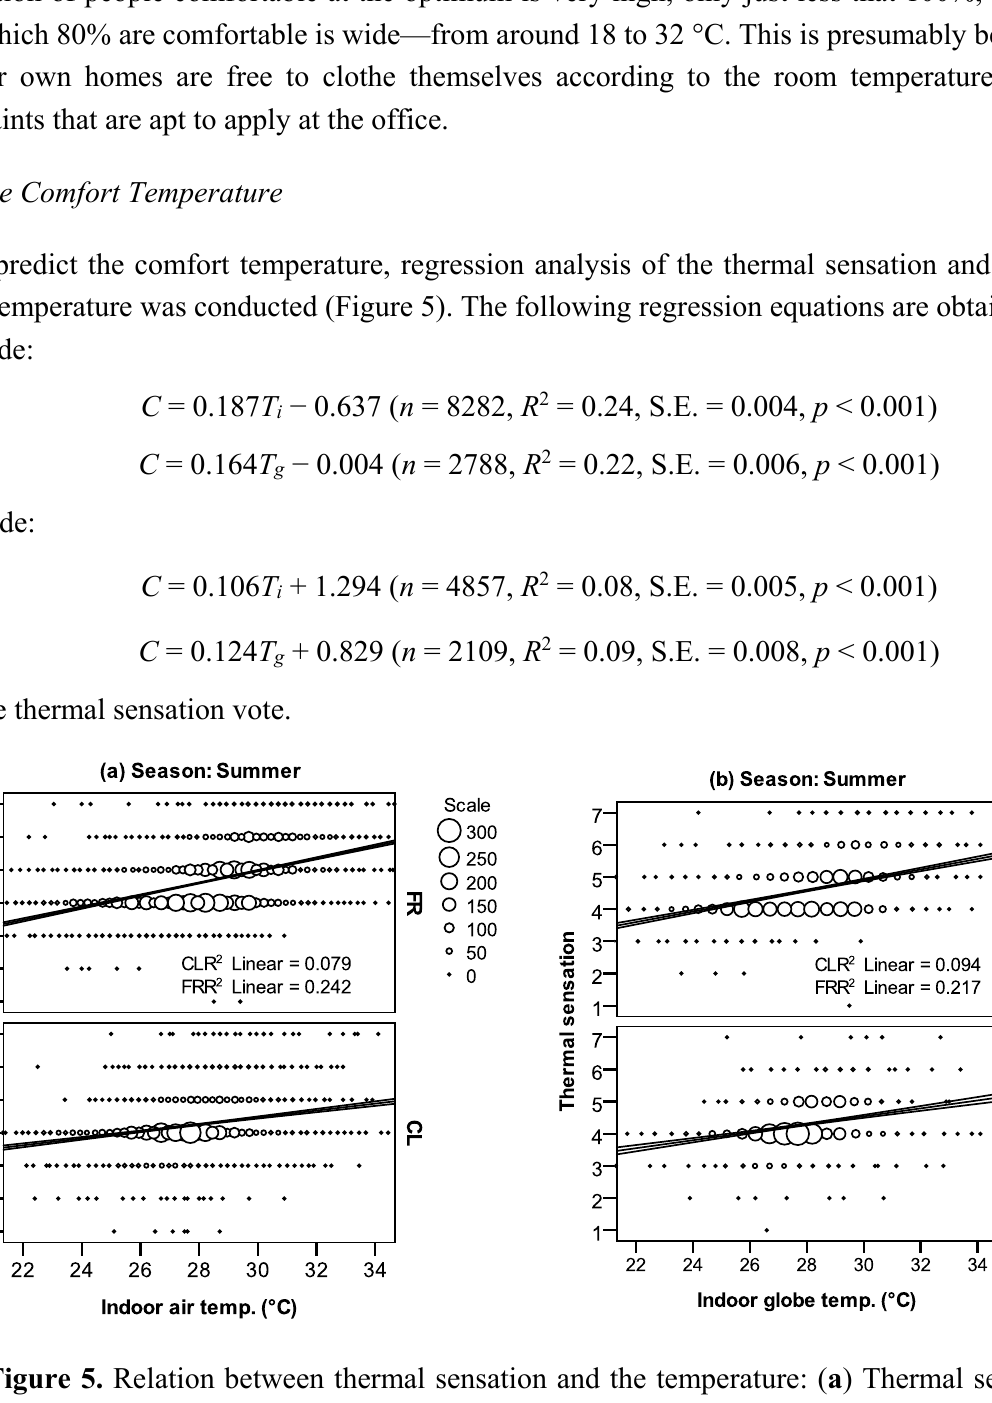
Figure 5. Relation between thermal sensation and the temperature: ( a ) Thermal sensation and indoor air temperature; ( b ) Thermal sensation and indoor globe